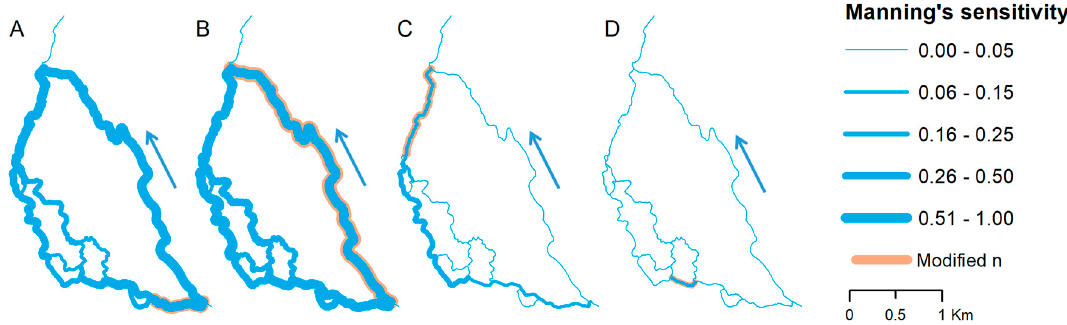
Figure 7. Flow distribution changes as a response to Manning’s n alteration in: ( A ) Reach 2; ( B ) Reach 19; ( C ) Reach 21; and ( D ) Reach 6, representing winter conditions. Blue arrow indicates direction of flow. Reach numbering according to Figure 4.